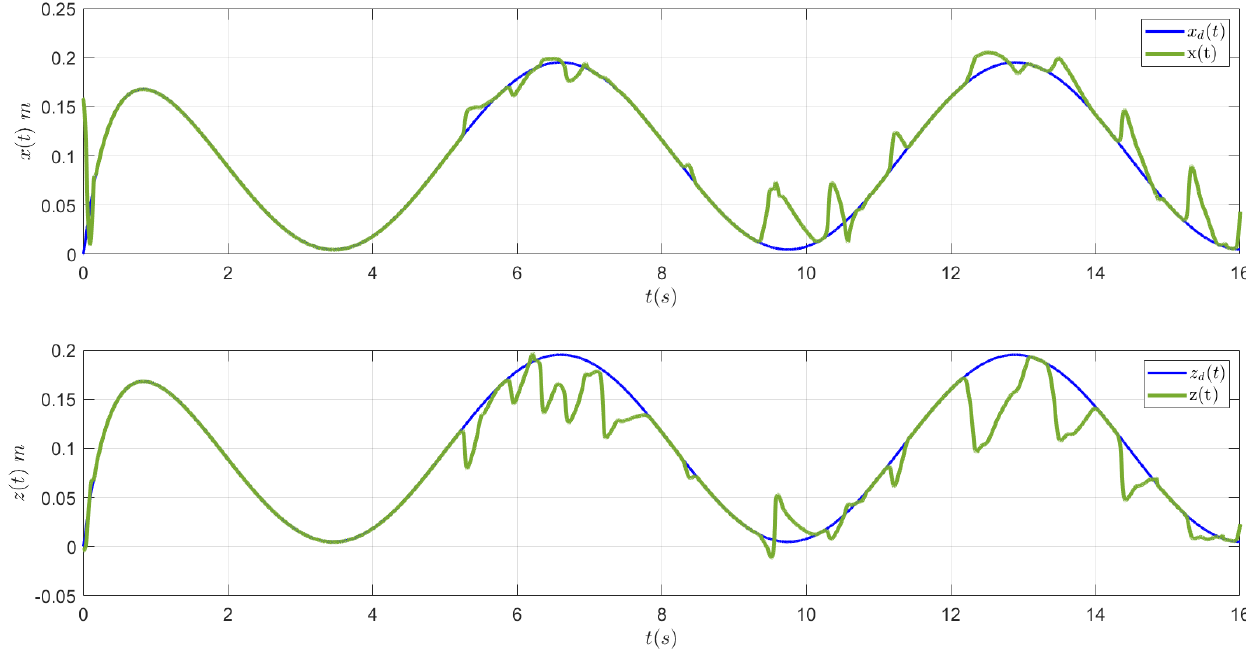
Figure 15. Faulty shoulder flexion and shoulder abduction